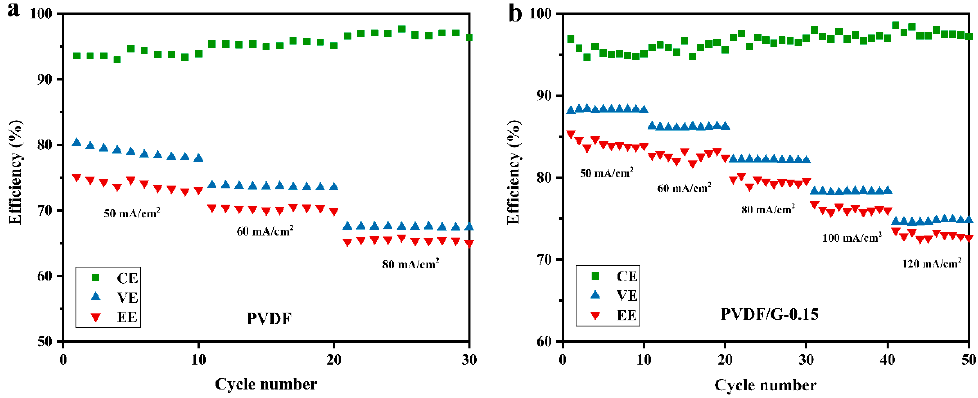
Figure 9. E ffi ciency variation with current density for di ff erent membranes: ( a ) PVDF; ( b ) PVDF / G-0.15. Figure 9. Efficiency variation with current density for different membranes: ( a ) PVDF; ( b ) PVDF/G- 0.15.